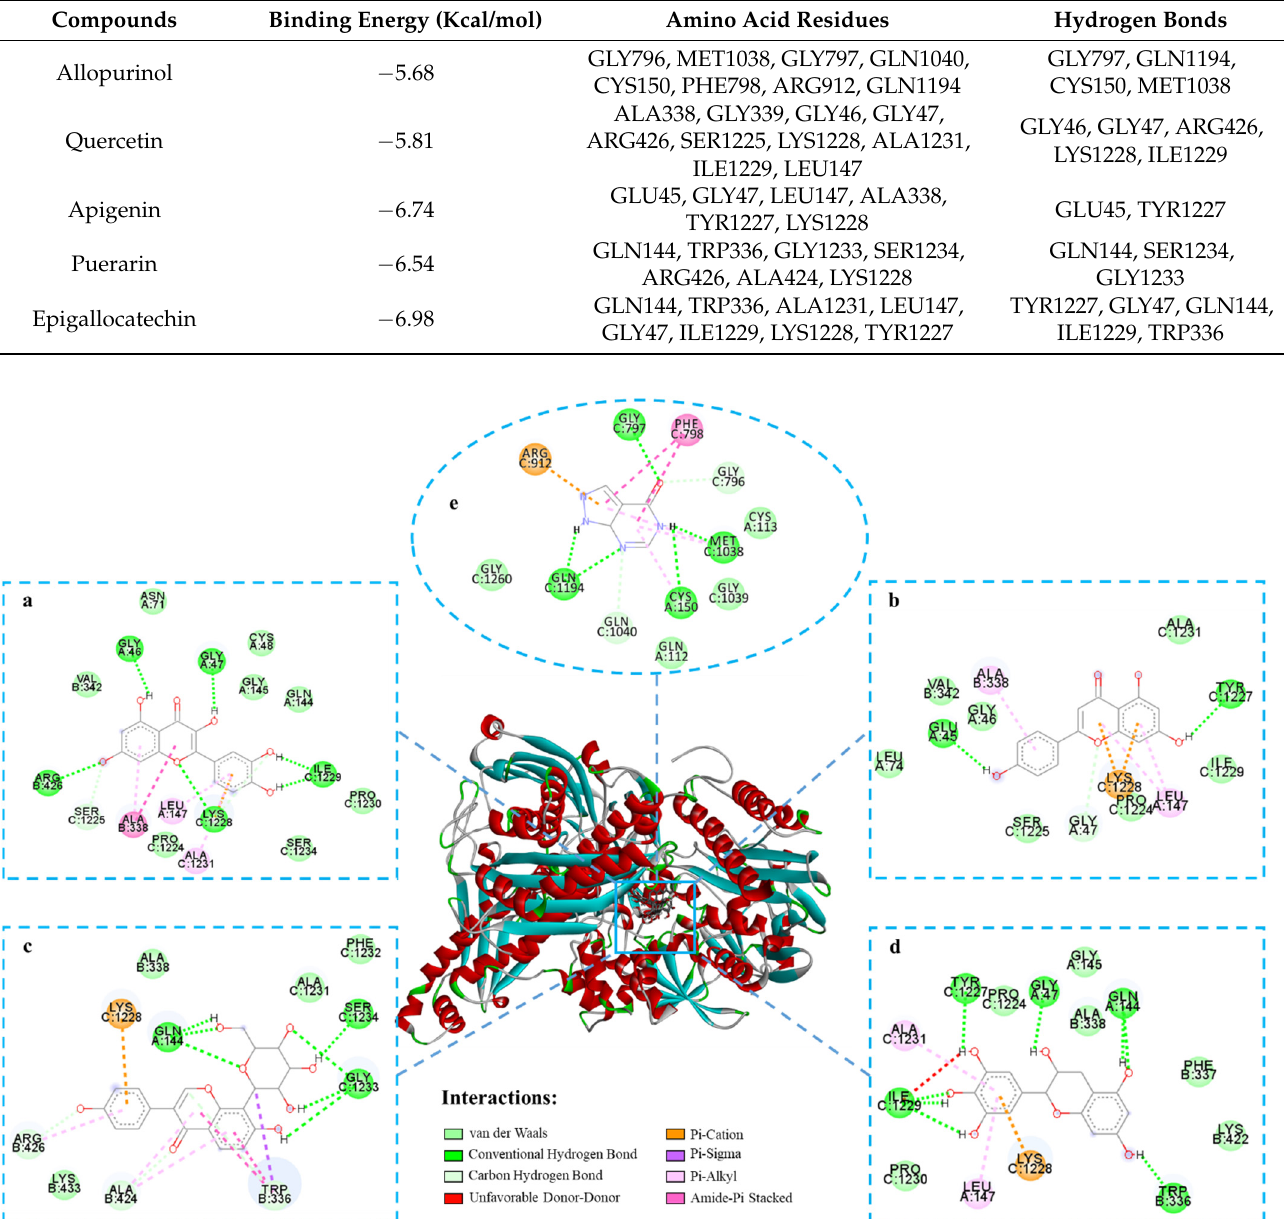
Table 2. Docking results of four flavonoids and allopurinol with XOD.